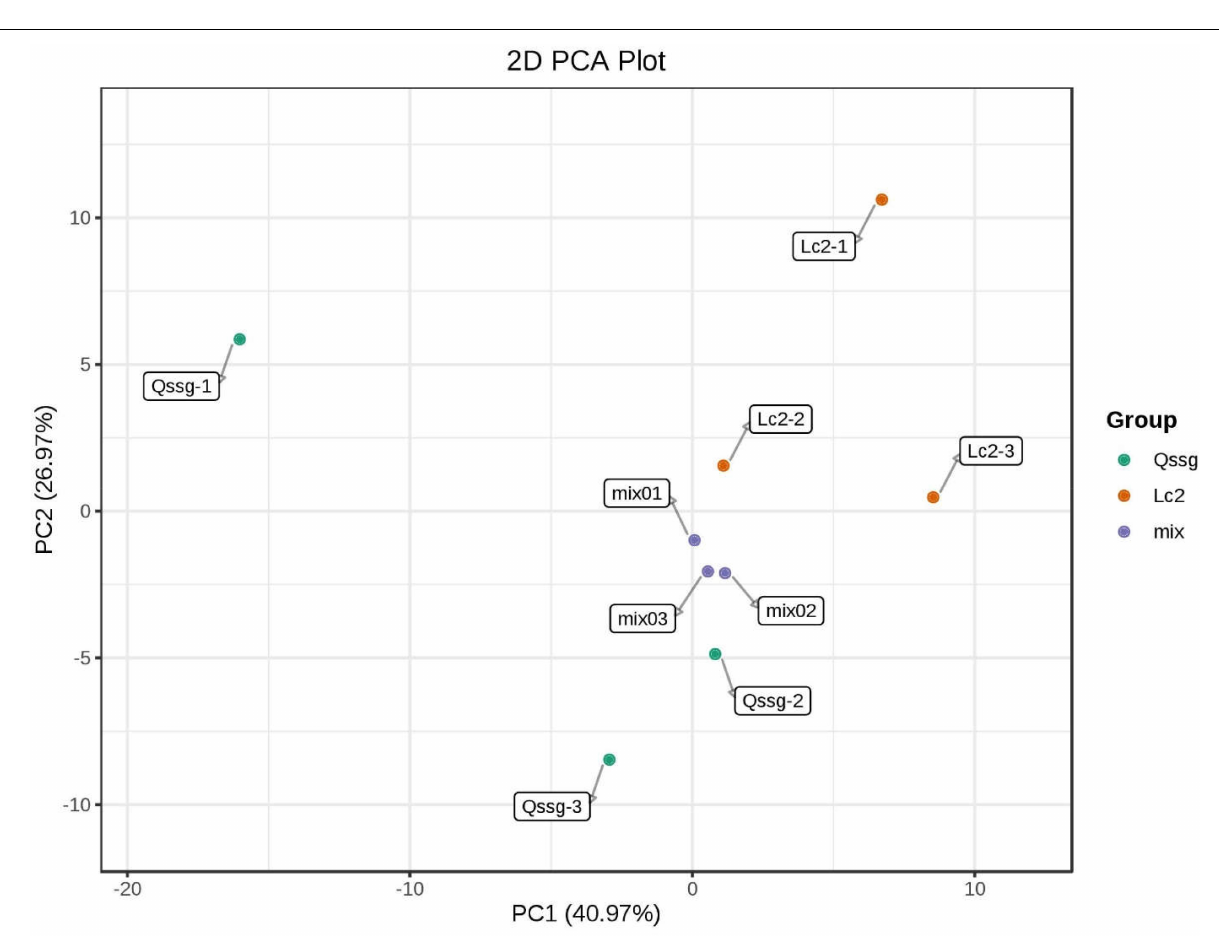
Frontiers in Plant Science |